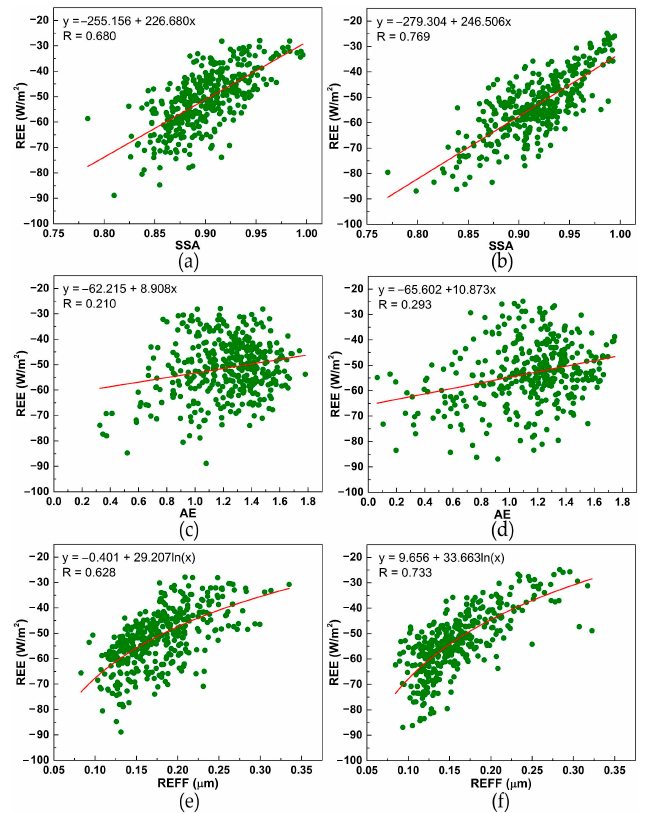
Figure 13. Dependence of REE on SSA in ( a ) Wuhan and ( b ) Dengfeng, AE in ( c ) Wuhan and ( d ) Dengfeng, and REFF in ( e ) Wuhan and ( f ) Dengfeng.